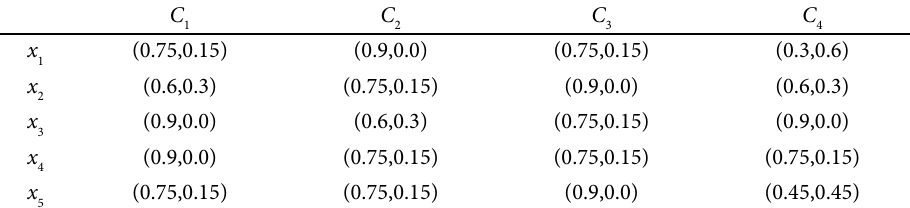
Table 3. Intuitionistic fuzzy decision